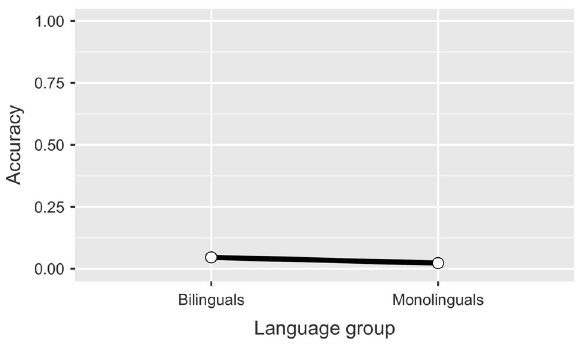
Fig. 8 Accuracy in rejecting the incongruent stimuli. The comparison is between the bilingual participants of the present experiment and the monolingual participants of Leivada & Westergaard (2019).